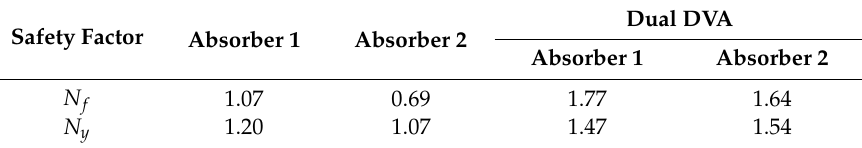
Table 8. Fatigue and yielding safety factors of the absorber’s beams for c a = 0.0002 k a